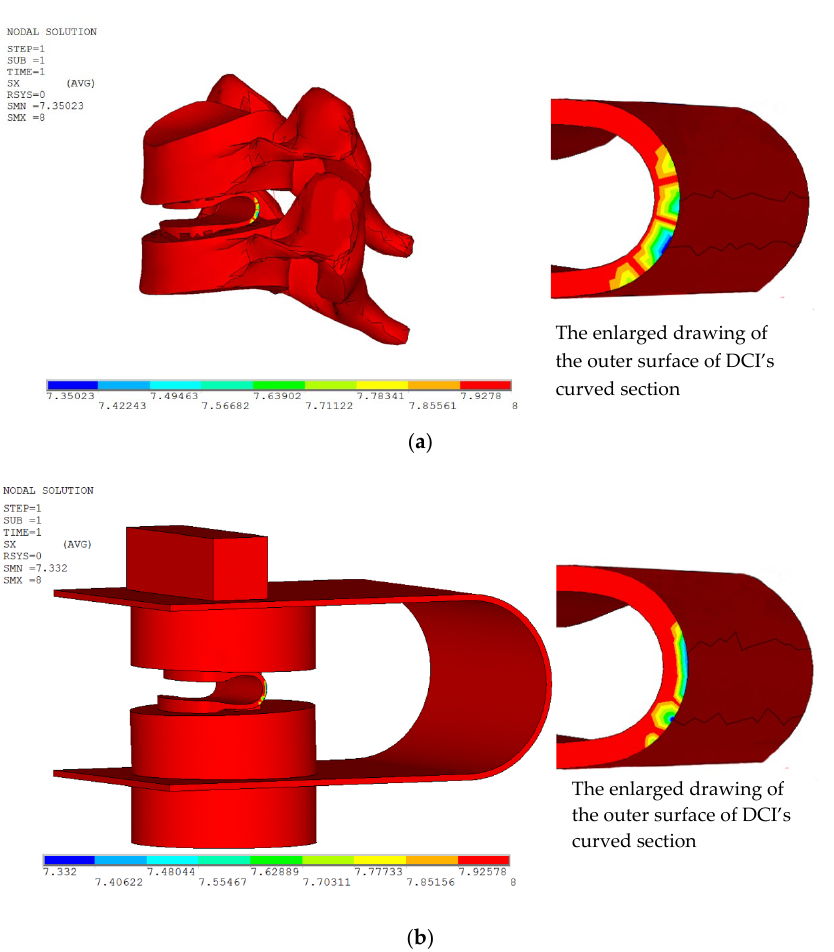
Figure 7. The contours of the fatigue life of pure Ti DCI under the flexion condition: ( a ) within C5–C6 cervical spinal segments; ( b ) within the fatigue-testing fixture.